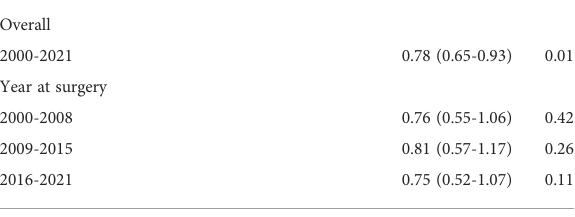
TABLE 3 Hazard ratios (HRs) for overall mortality among patients undergone sphincter-preserving surgery compared with APR by year